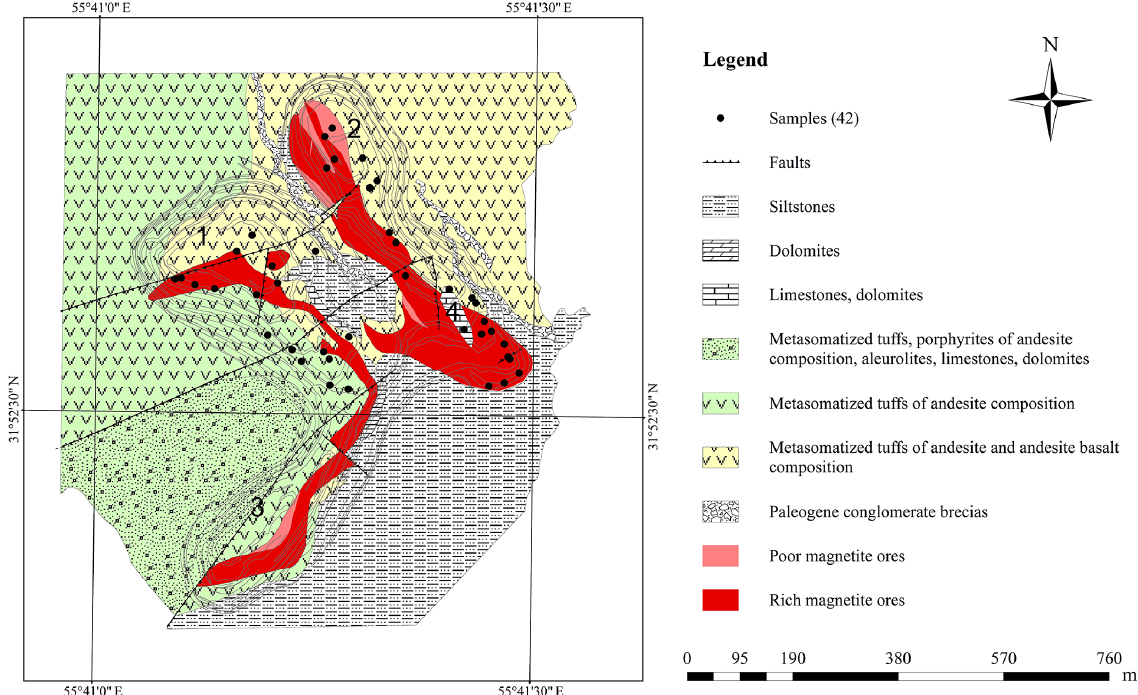
Figure 1. Geological map of Se-Chahun deposit (anomaly X) and sample locations. Contours of open pits are shown on the map, and the open pits are numbered from 1 to 4 (supplementary part of pit 2 is known as pit 4) (modified after NISCO, 1975).